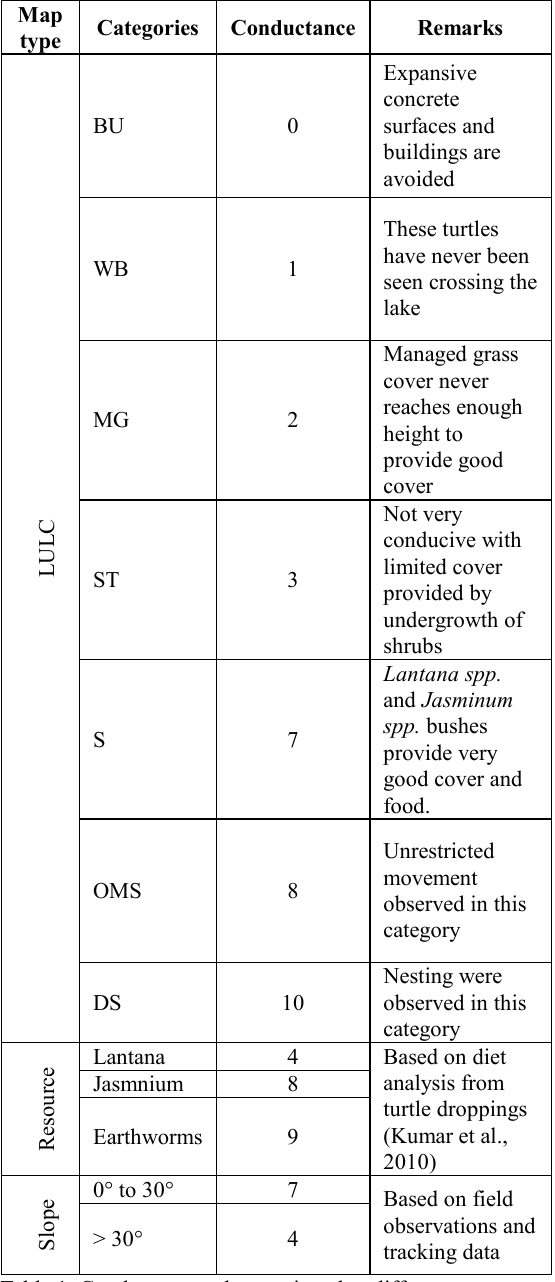
Table 1. Conductance values assigned to different map